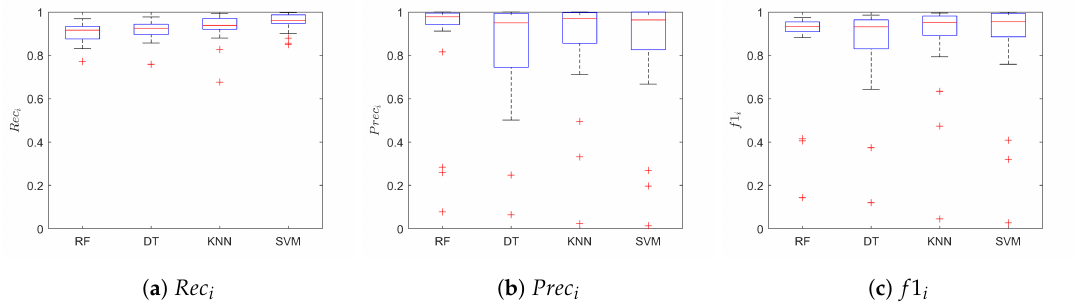
Figure 7. Classification results obtained on the LDV-beat dataset. Results are shown in terms of: ( a ) recall ( Rec i ), ( b ) precision ( Prec i ), and ( c ) f1-score ( f 1 i ) for the class i = beat . The results are obtained when using Random Forest (RF), Decision Tree (DT), K-Nearest Neighbor and Support Vector Machines (SVM). Table 1. Classification performance obtained when classifying the LDV-beat dataset with Random Forest (RF), Decision Tree (DT), K-Nearest Neighbors (KNN) and Support Vector Machine (SVM) classifiers. Classification recall ( Rec i ), precision ( Prec i ), and f1-score ( f 1 i ) are reported for the class beat ( i = 1) and no-beat (i = 0). Prec Rec f 1 Beat